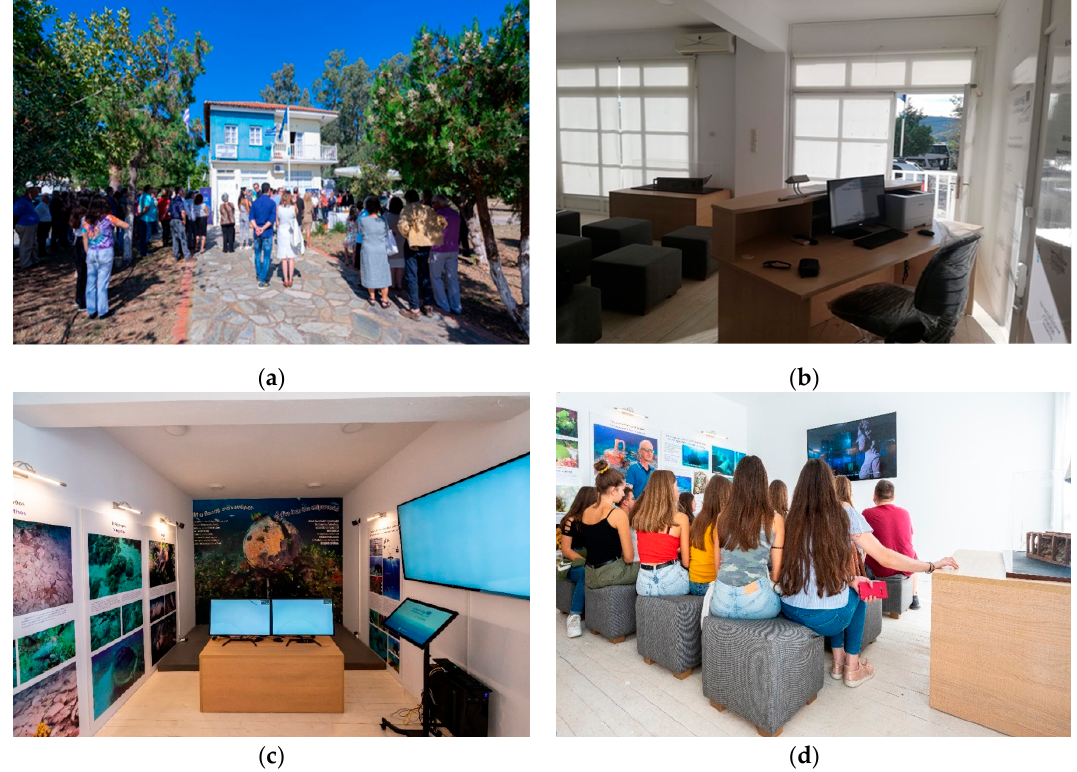
Figure 12. Some pictures of the Amaliapolis KAC: ( a ) Building of the Coastal Amaliapolis Fund where the KAC is located; ( b ) Entrance and Reception desk; ( c ) “Exhibition” room; ( d ) “Conference” room.